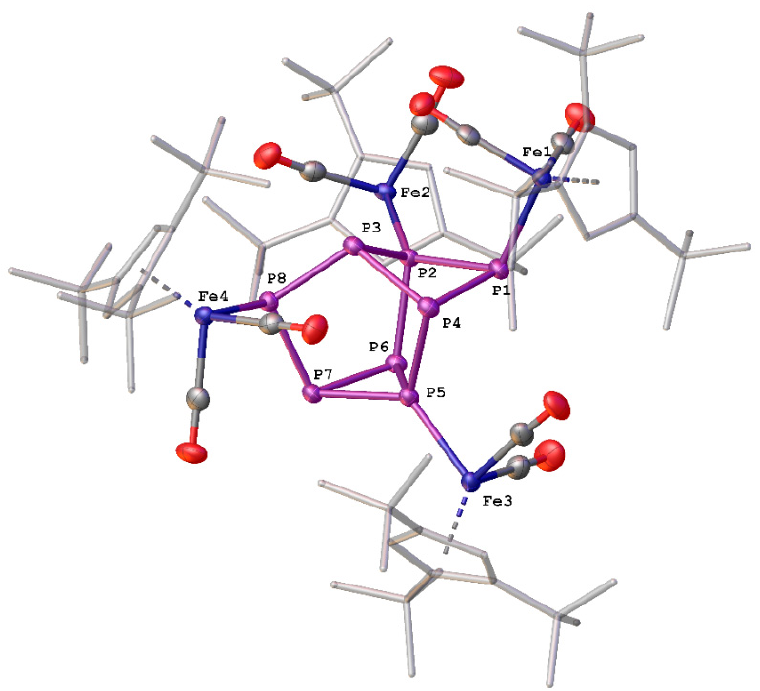
Figure 4. Cationic part of the molecular structure of 5 in the solid state. Hydrogen atoms, solvent molecules and counter ions are omitted for more clarity. Selected bond lengths (Å)—Fe4-P8 2.2756(5), Fe3-P5 2.2468(5), Fe2-P2 2.2587(5), Fe1-P1 2.3040(5), P5-P6 2.2115(7), P5-P7 2.1916(7), P5-P4 2.2134(7), P2-P3 2.1890(7), P2-P6 2.2713(6), P2-P1 2.2758(7), P3-P8 2.1612(7), P3-P4 2.2062(7), P6-P7 2.2071(6), P8-P7 2.1925(7), P4-P1 2.2402(7).